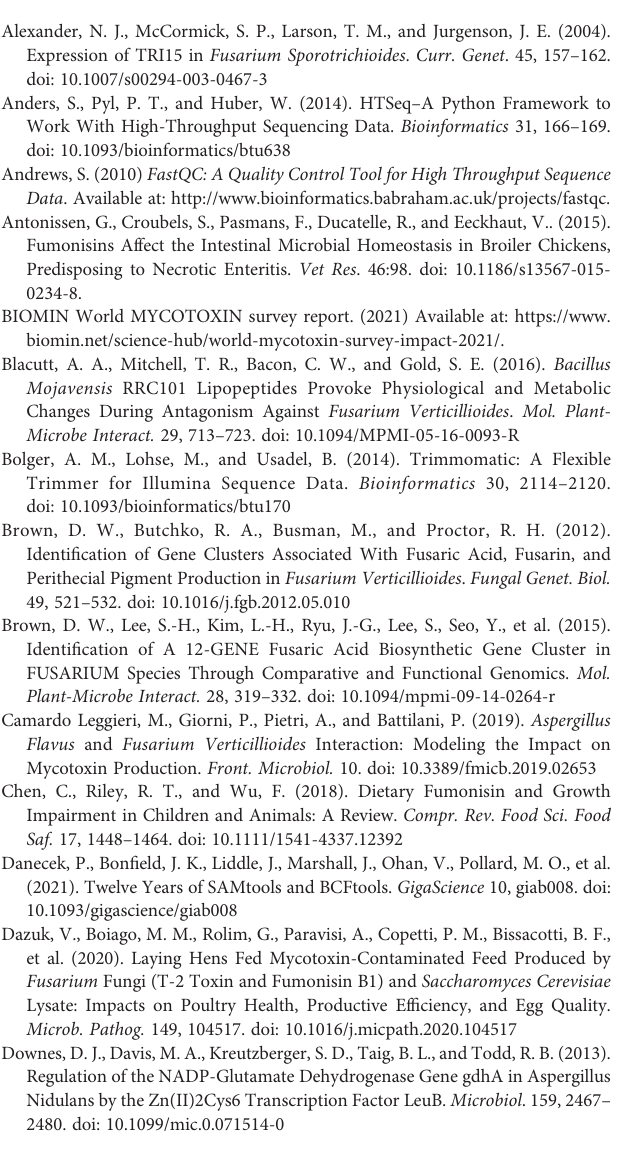
Supplementary Figure 4 | Differential expression time course of F. verticillioides gene encoding for transcription factors, secondary metabolism clusters, and secretome in response to dual-culture with Streptomyces strain s2831. A list of identi fi ed and predicted genes corresponding to transcription factors, secondary metabolism, and secretome was compared to DEGs from the s2831 dataset and represented as Venn